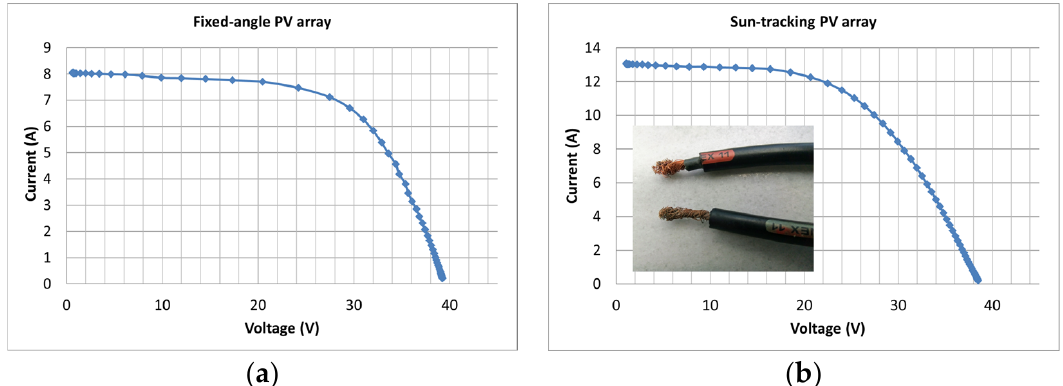
Figure 8. The I–V characteristics of two identical PV generators ( a ) at a fixed angle and ( b ) sun- tracking. The photo in ( b ) shows corrosion in one lead of the cable.